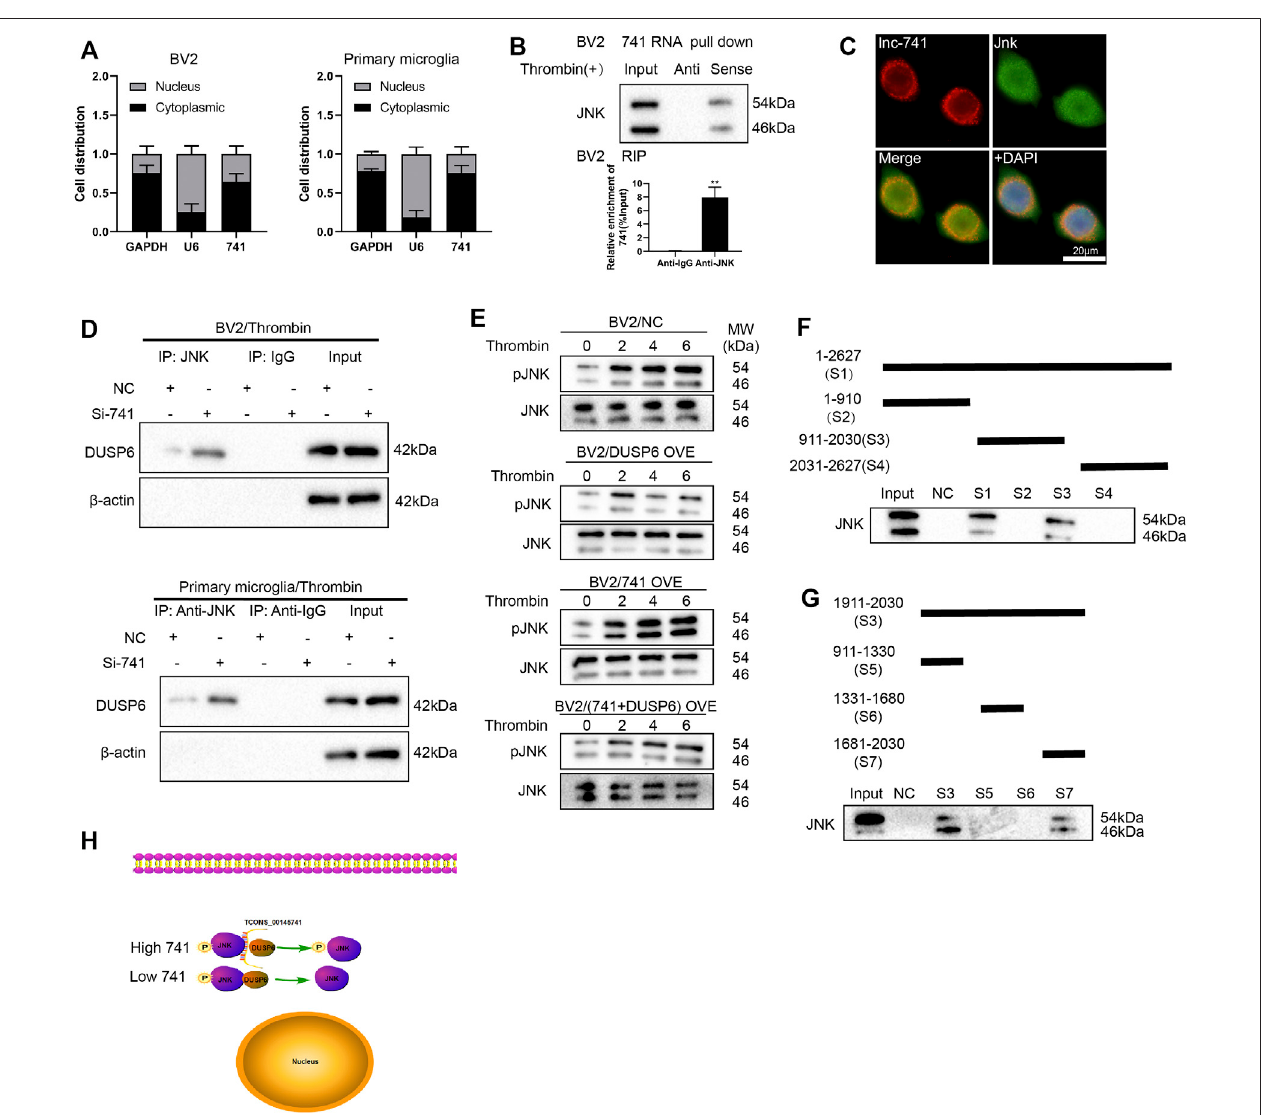
FIGURE 5 | TCONS_00145741 regulates the level of JNK phosphorylation by disrupting the interaction between DUSP6 and JNK. (A) BV2 cells and primary microglia were treated with 20 U/ml thrombin for 24 h. Detection of TCONS_00145741 expression in the cytoplasm and nucleus of cells by qRT-PCR. (B) RNA pull- down and RNA immunoprecipitation assays were carried out to verify that TCONS_00145741 combined with JNK protein. (C) RNA FISH followed by immuno fl uorescence analysis was applied to analyze the co-localization of TCONS_00145741 and JNK in microglia (Scale bar (cid:2) 20 μ m). (D) TCONS_00145741 was silenced in BV2 cells and primary microglia and then the cells were treated with 20 U/ml thrombin for 24 h. Detection of the protein level of DUSP6 by Western blot. (E) TCONS_00145741and/orDUSP6wereoverexpressedinBV2cellsandthenthecellsweretreatedwiththrombinfor0,2,4,and6 h.Detectionoftheproteinlevelsof pJNKandJNK. (F – H) AseriesofTCONS_00145741truncatedsegmentsweredesignedtoclarifythebindingsitesofTCONS_00145741thatinteractedwithJNK.** p < 0.01 vs. Anti-IgG.